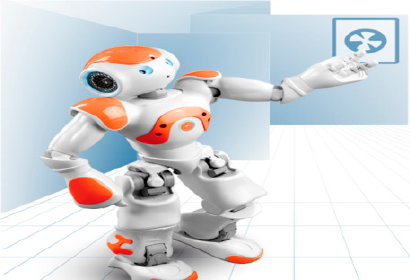
Figure 4. A talking objects participant places an augmented reality (AR) marker on a display case.